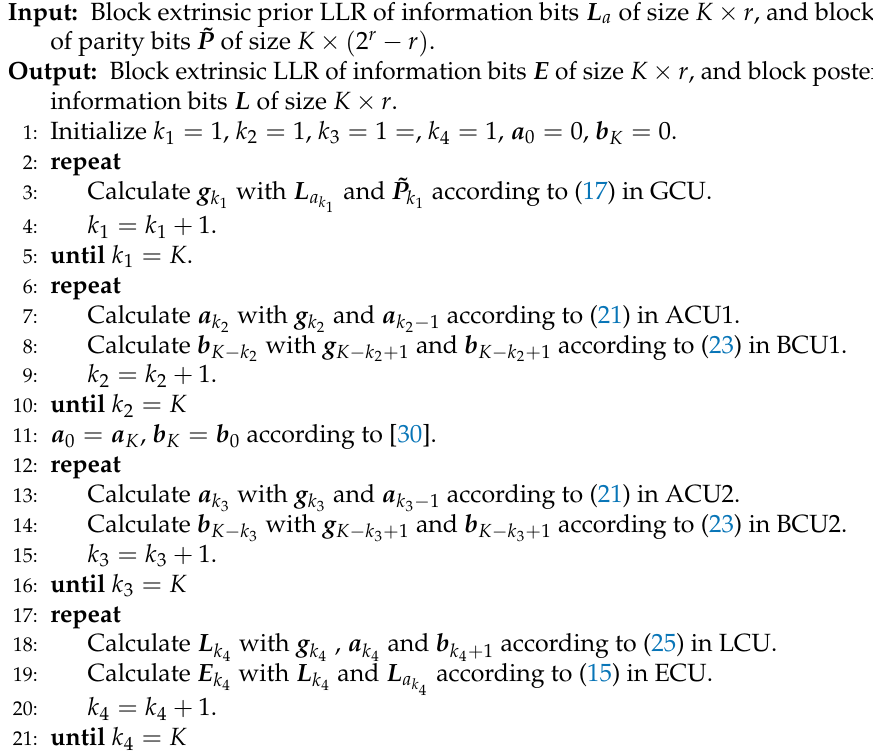
Algorithm 2 Tail-Biting Convolutional-Hadamard APP Decoder